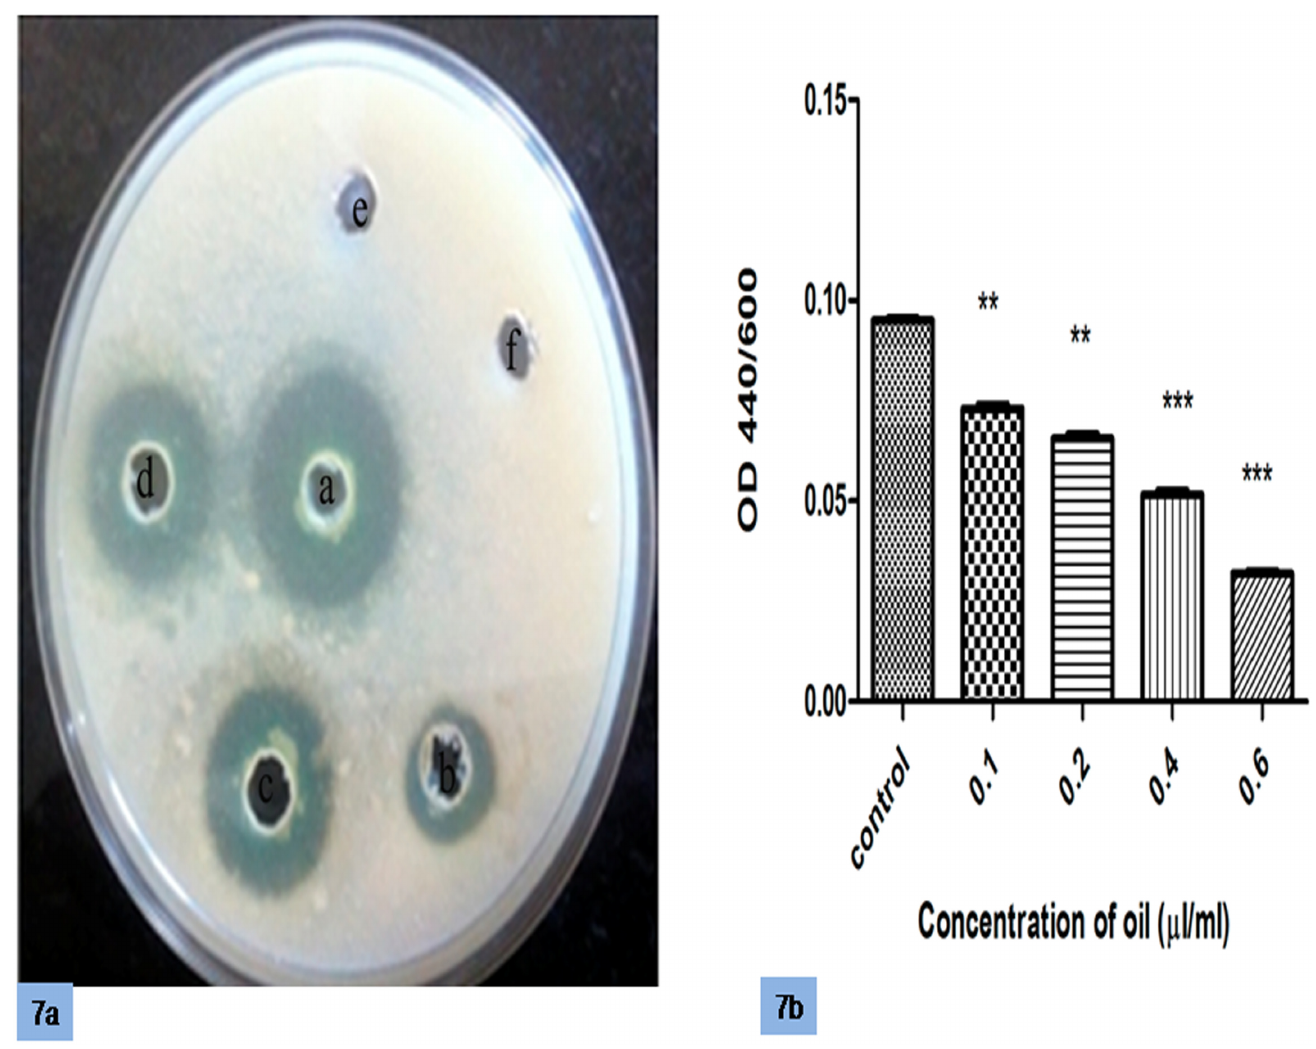
Fig 7. (a) Detection of the inhibition of protease production by cinnamon oil on skimmed milk agar plates (a-control, b-0.1, c-0.2, d-0.4, e-0.6 μ l/ml). (b) Effects of different concentrations of cinnamon oil on the production of protease. Error bars indicate the standard deviations of three measurements, and the data were normalized according to the OD 600 . ** , P < 0.001 compared with the control. *** P < 0.0001 compared with the